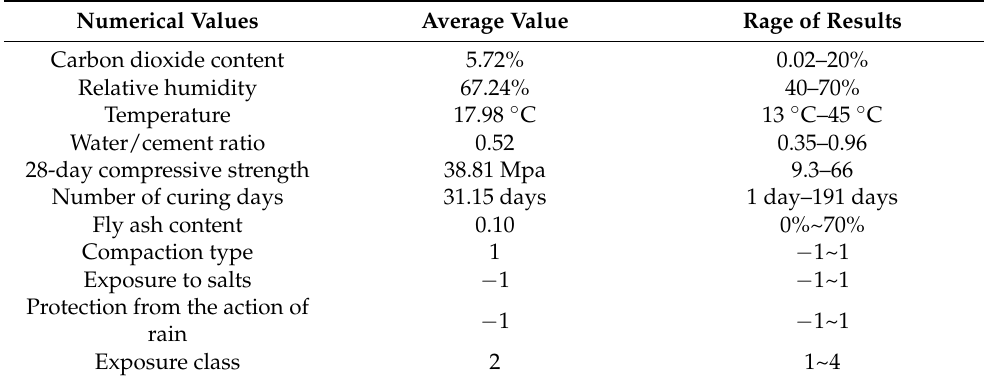
Table 2. Characterization of the variables with RH less than 70% after removing the